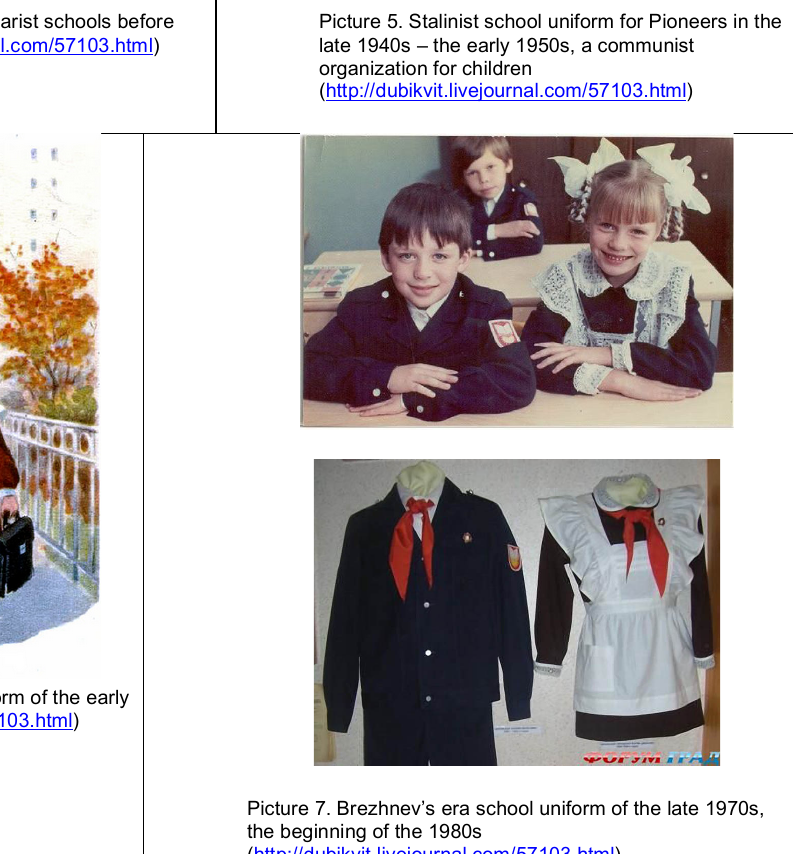
Picture 6. Khrushchev’s era school uniform of the early 1960s (http://dubikvit.livejournal.com/57103.html)